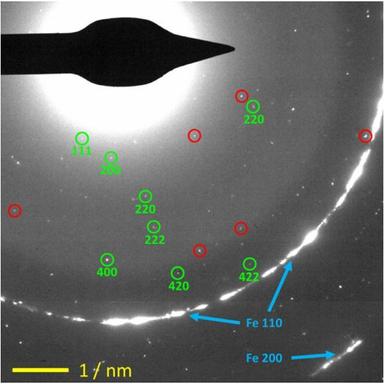
Subset of a selected area diffraction (SAD) pattern recorded in ODS_AC_RT. The contrast is artificially increased to visualize the weaker diffraction spots. Blue arrows point to the 110 and 200 diffraction rings of the iron grains. Green circles correspond to reflections from M23C6 carbides, red circles indicate particles with lattice constants different from M23C6. (For interpretation of the references to color in this figure legend, the reader is referred to the web version of this article.)